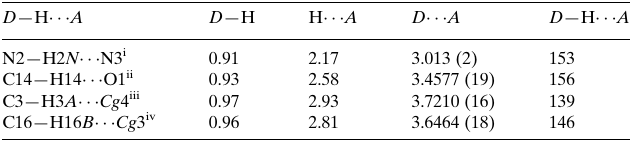
Hydrogen-bond geometry (A˚ , (cid:2) ). Cg 3 and Cg 4 are the centroids of the methyl- and chloro-benzene rings (C10– C15 and C18–C23),